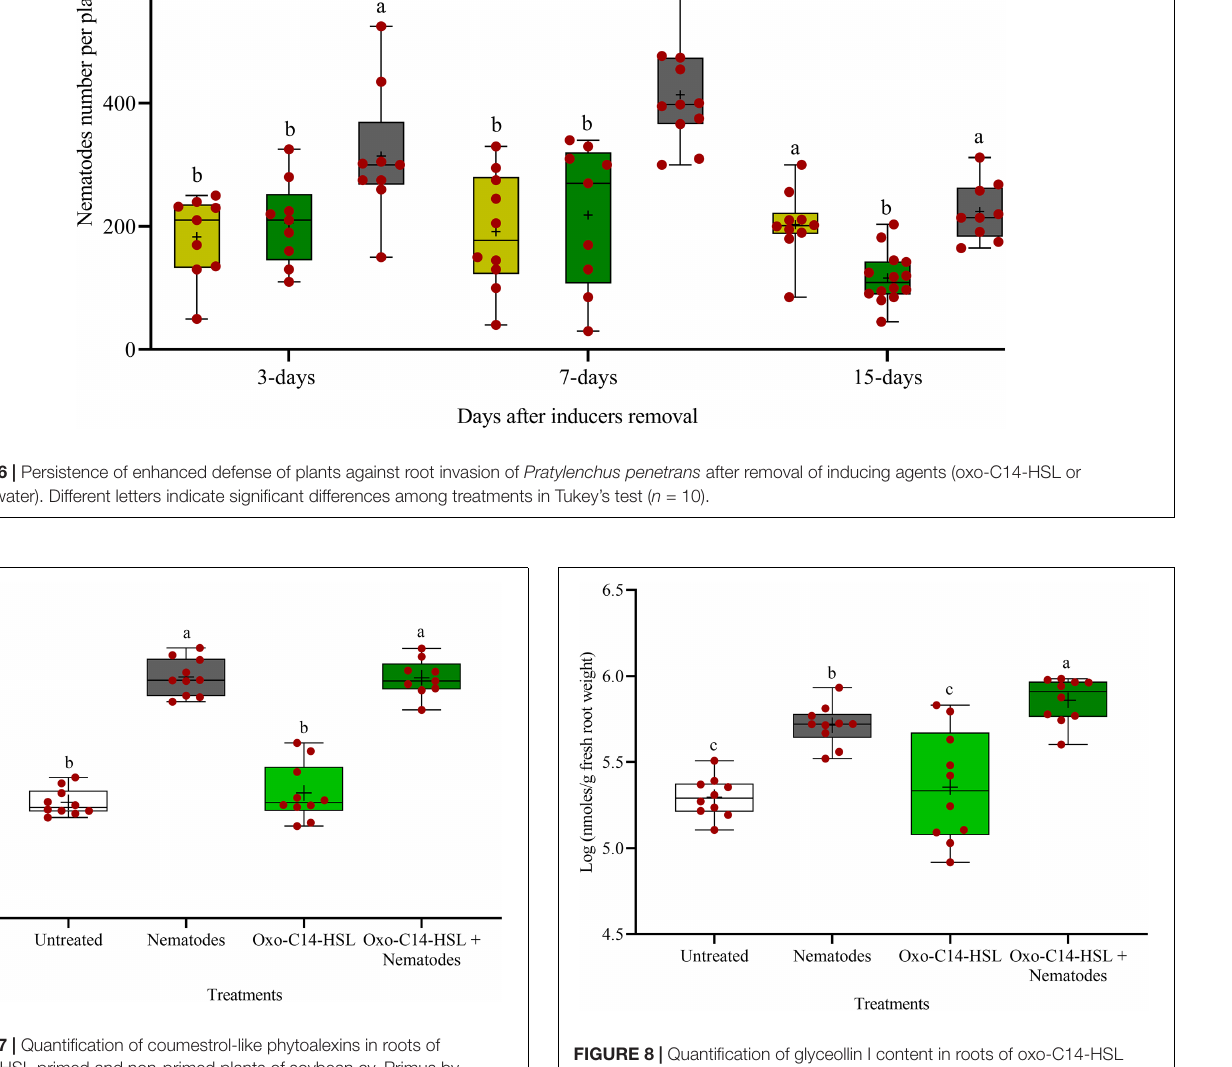
FIGURE 8 | Quantification of glyceollin I content in roots of oxo-C14-HSL primed and non-primed plants of soybean cv. Primus by high-performance liquid chromatography. The mean of glyceollin content in roots is shown as (+) for each treatment, while the medians are shown as (–). Different letters indicate significant differences among treatments in Tukey’s test ( n =